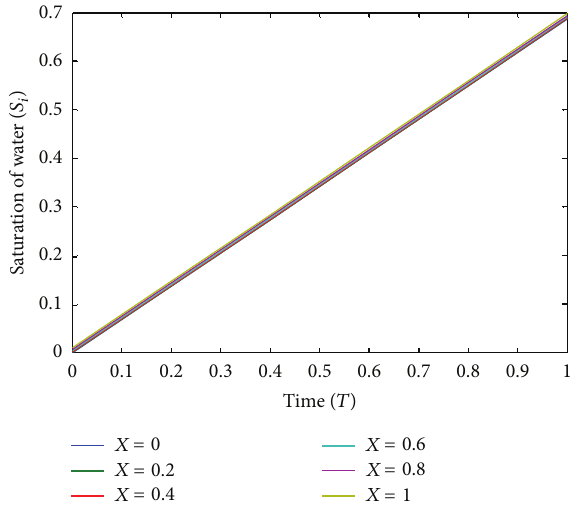
Figure 3: The plot of time ( 𝑇 ) versus saturation of water ( 𝑆 𝑖 ) for different values of distance ( 𝑋 ).